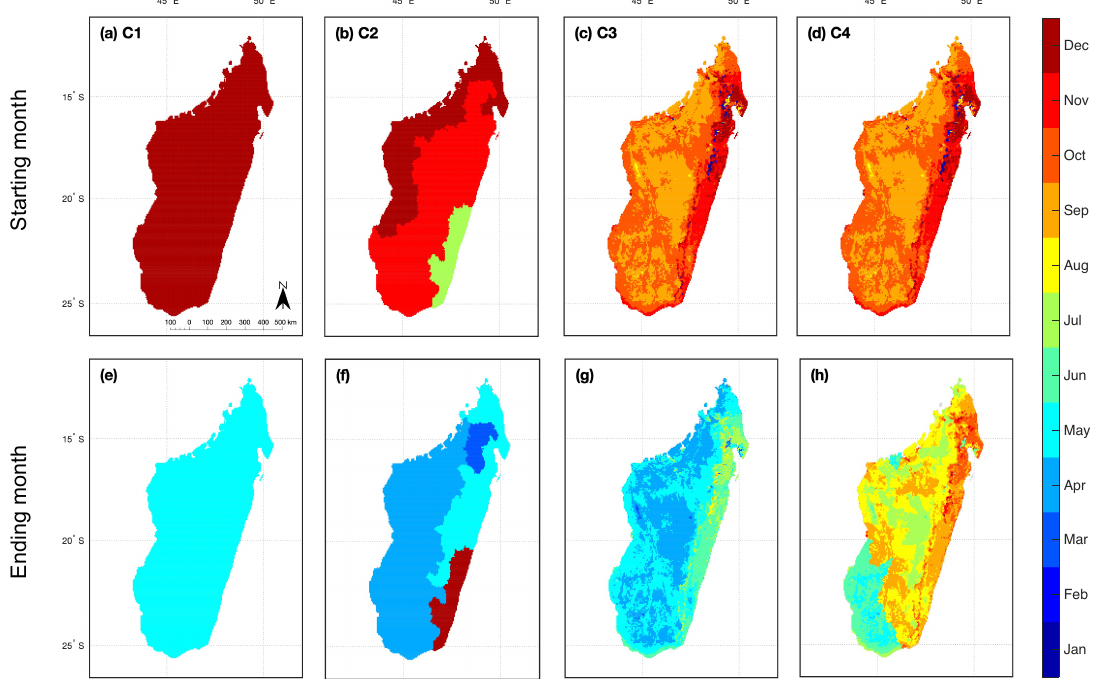
Figure 3. The four calendars used to temporally average soil moisture anomalies for comparison with rice production anomalies (see Figures S5–S7 for analogous plots of cassava, maize, and sweet potato). The top row represents the starting month of the temporal average for calendars ( a ) C1, ( b ) C2, ( c ) C3, and ( d ) C4. The bottom represents the ending month of the temporal average for calendars ( e ) C1, ( f ) C2, ( g ) C3, and ( h ) C4. C1 and C2 represent mean planting (start) and mean harvesting (end) dates, while C3 and C4 represent temporal periods based on NDVI. For C2 ( b , f ), we have mapped the rainy season calendar (see Fig S8 for separate maps of the rainy and dry seasons and Supplementary Data 1 for details on C2). The starting month for C3 ( c ) and C4 ( d ) are identical, as they represent the minimum in NDVI after the climatological seasonal cycle is smoothed with a 5-month moving window. For all calendars, the starting month can be in the year prior to